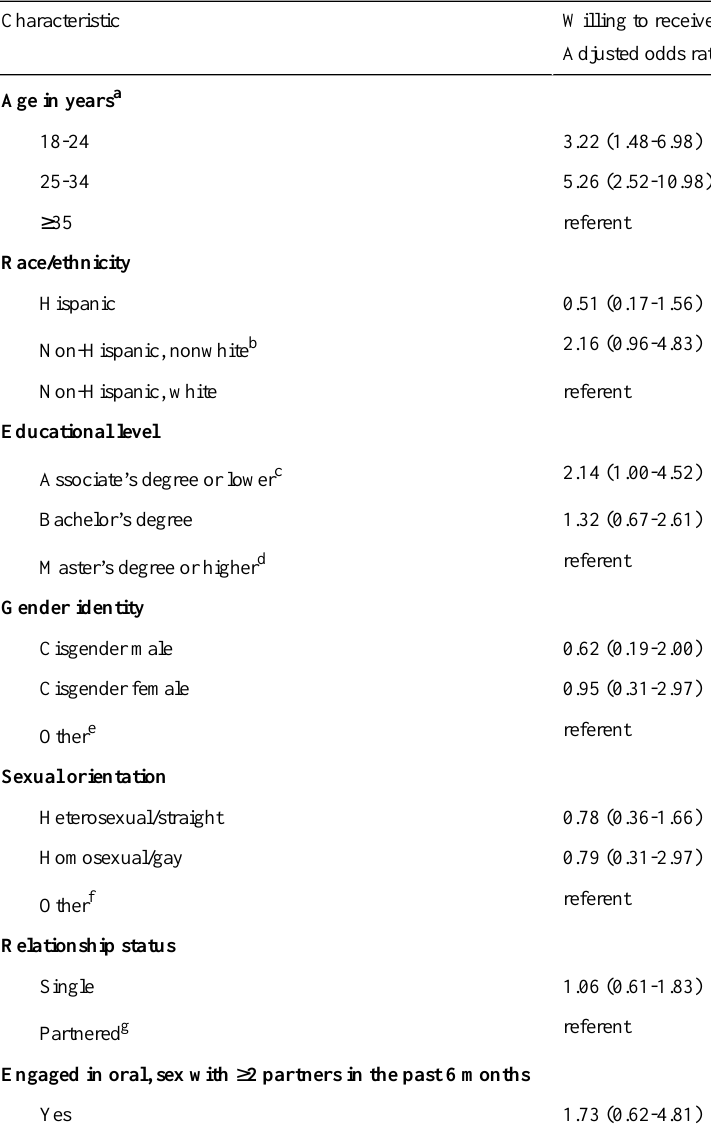
Table 3. Factors associated with willingness to receive any type of HIV testing in a dental care setting, United States, December 2018 to February